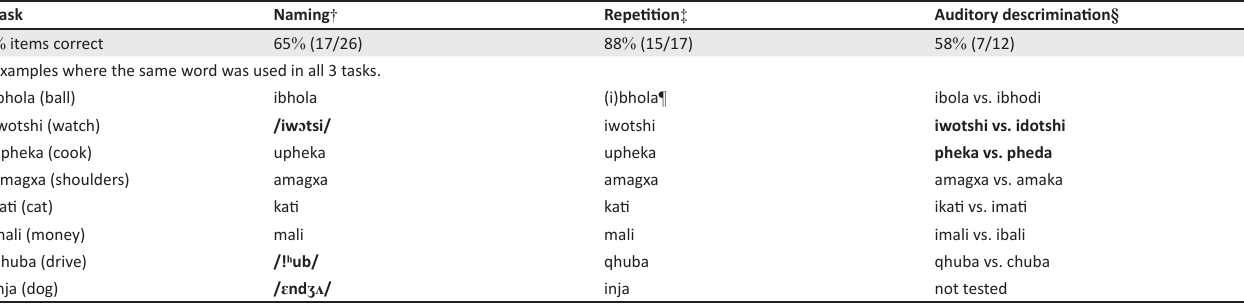
TABLE 1: Summary of Child A’s performance across the three tasks.